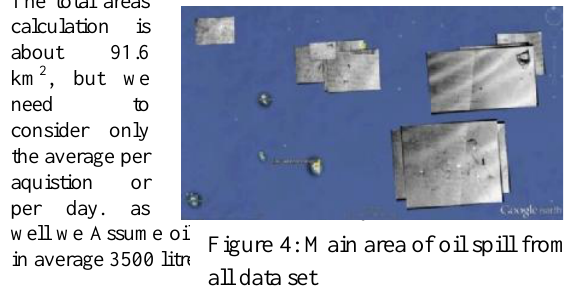
Figure 6: Analysis and comparison of three successive data contained oil